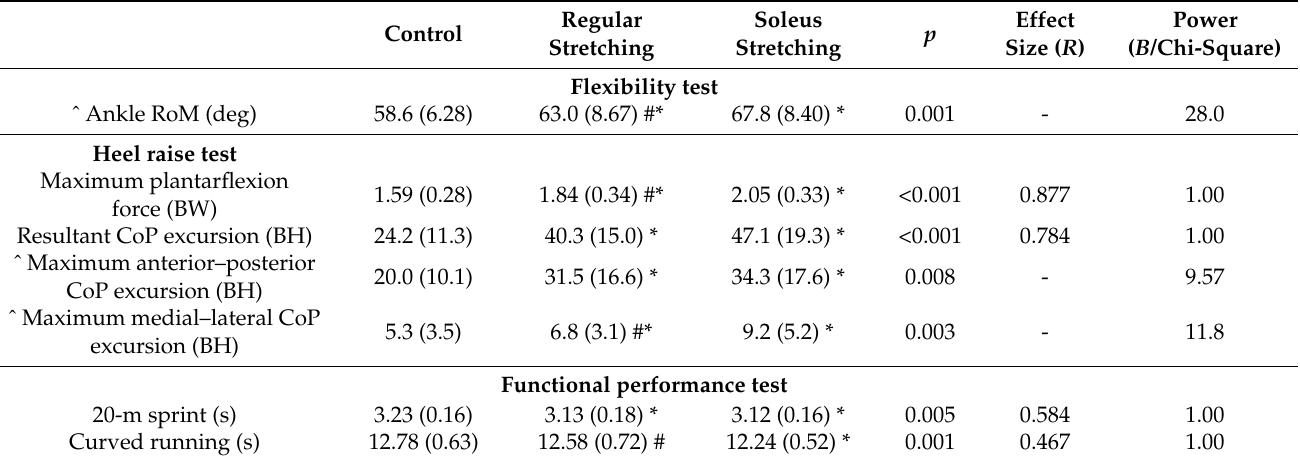
Table 2. The statistical results for ankle flexibility, standing heel raise and speed performance tests under three stretching conditions (Raw GRF data can be found in Table